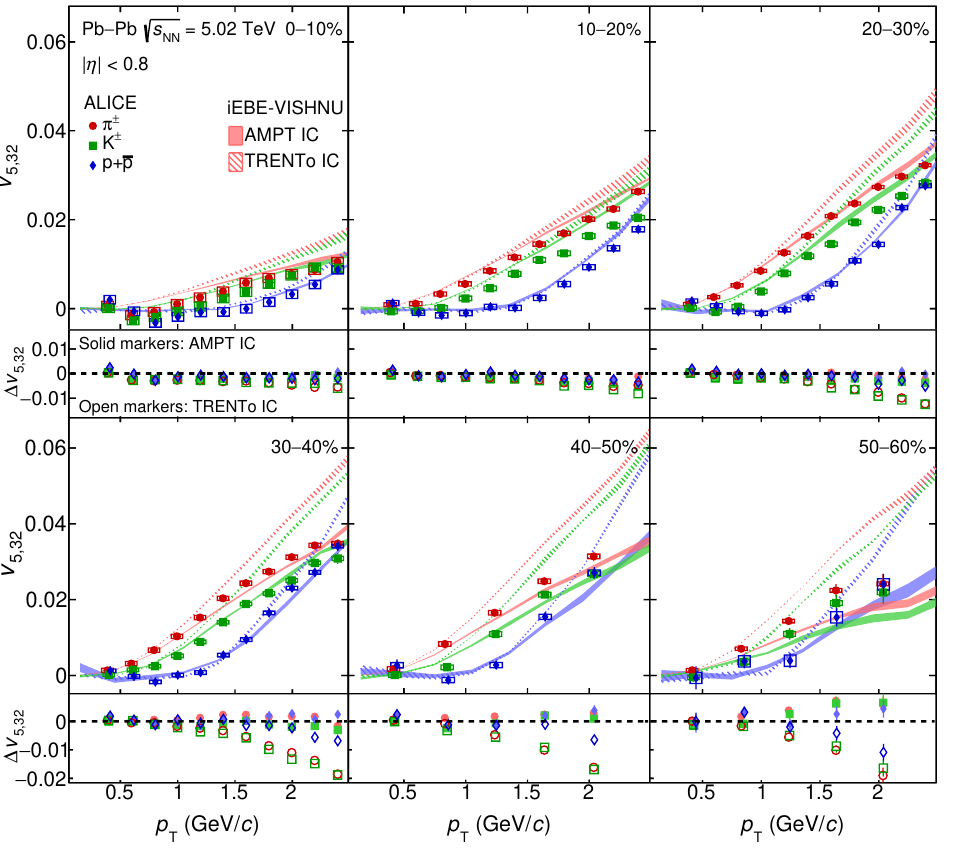
Figure 16 . The p T -di(cid:11)erential v 5 ; 32 of (cid:25) (cid:6) , K (cid:6) and p + p in the 0{10% up to 50{60% centrality p intervals of Pb-Pb collisions at s NN = 5 : 02 TeVcompared with iEBE-VISHNU hybrid models with two di(cid:11)erent sets of initial parameters: AMPT initial conditions ( (cid:17)=s = 0.08 and (cid:16)=s = 0) shown as solid bands and TRENTo initial conditions ( (cid:17)=s (T) and (cid:16)=s (T)) as hatched bands. The bottom panels show the di(cid:11)erence between the measurements and each model. Statistical and systematic uncertainties are shown as bars and boxes,